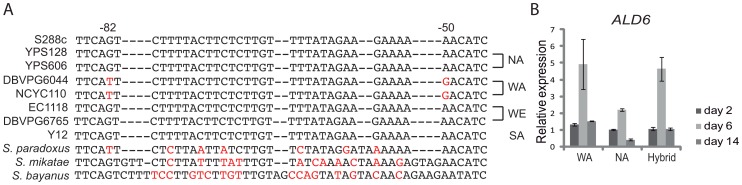
Higher expression levels of WA ALD6 are consistent with increased acetic acid production.(A) Analysis of promoter region of the ALD6 gene. Residue at positions −82 and −50 are evolutionary conserved in other Saccharomyces sensu stricto species but not in the West African lineage. Nucleotide changes with respect to the reference genome (S288c strain) are shown in red. (B) Expression of ALD6 in the parental and hybrid strain at three different time points of the fermentation process.